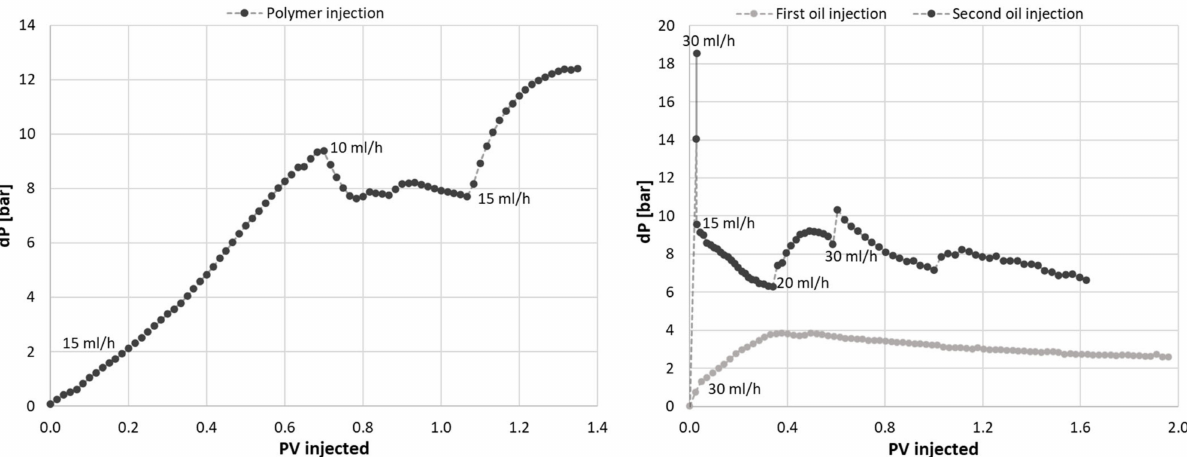
Figure 14. Differential pressure across the core plug during polymer injection ( left ) and subsequent oil injection ( right ), compared to the initial oil flood.